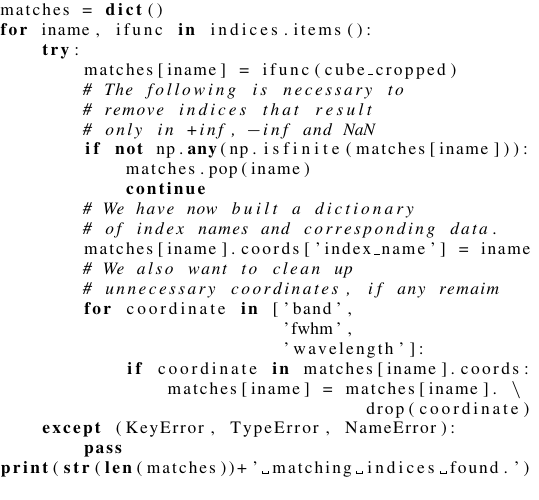
Figure 23. We loop through the indices, and take those that are sensible.